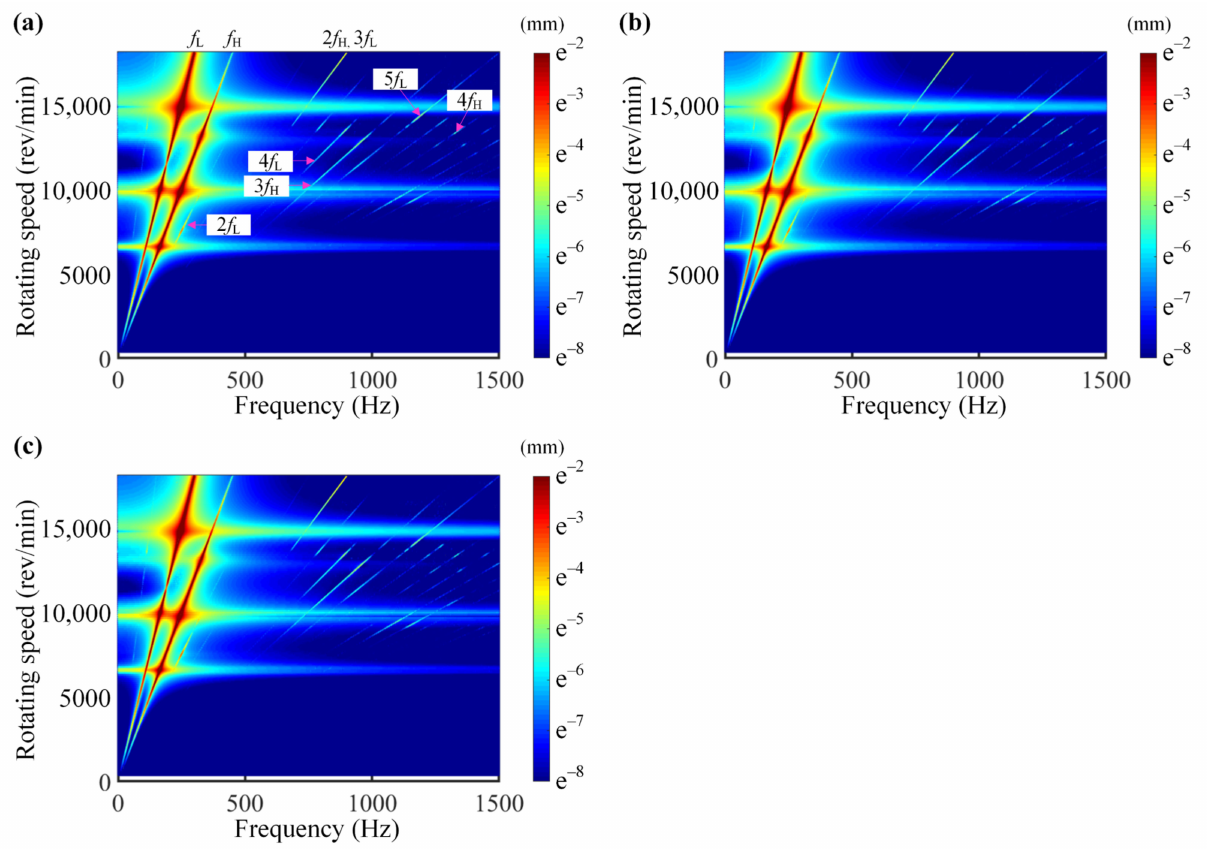
Figure 16. Spectrum cascades of ( a ) prototype and the prediction results from the models ( b ) M1 and ( c ) M2 under two frequency excitations.